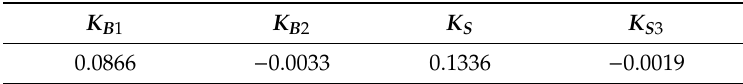
Figure 5. “All-fit” case plot: calculated values corresponding to each harvesting season are obtained using experimental values acquired during two harvesting seasons, as if they are from a single harvesting season. Table 4. Sets of calculated unknowns calculated using all the data available from both harvesting seasons (“all-fit” case).